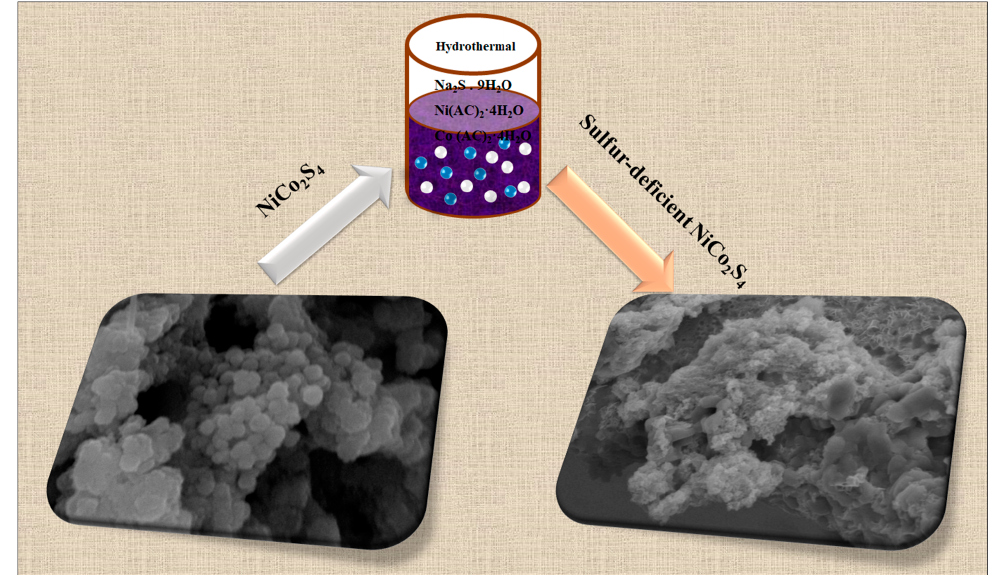
Figure 1. Schematic diagram illustrating the preparation of NiCo 2 S 4 electrode and sulfur-deficient NiCo 2 S 4 nanosheet composites on Ni foam substrate.